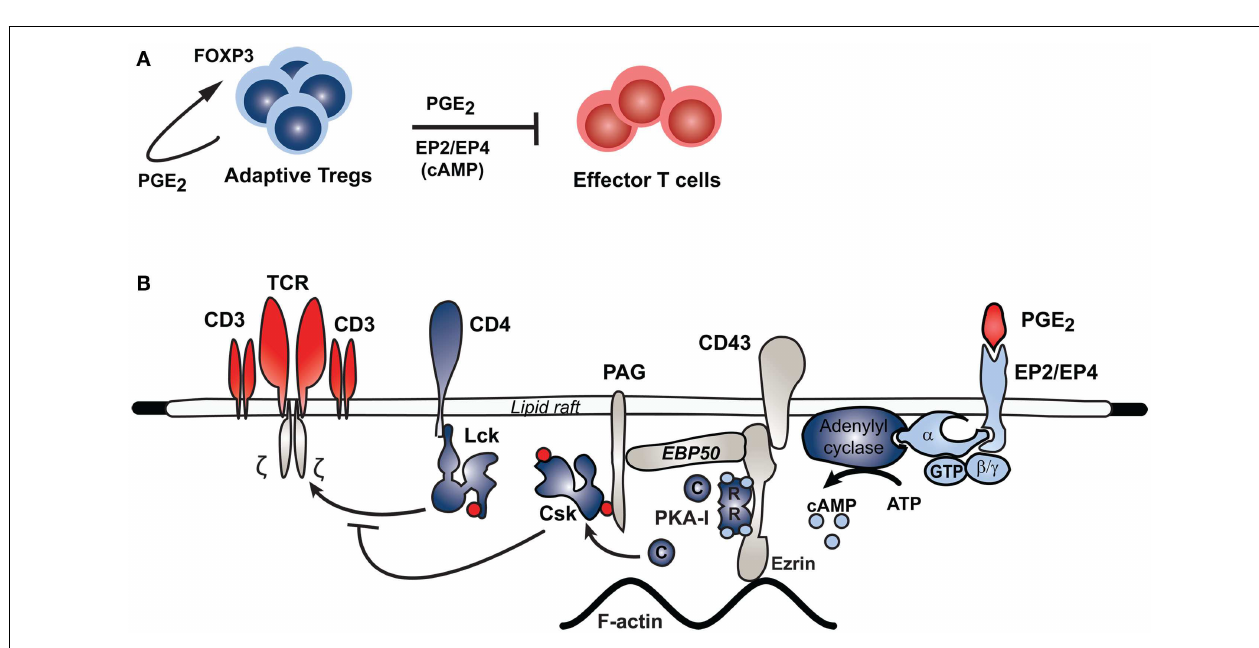
shown in (B) . Binding of PGE 2 to its receptors on effectorT cells stimulates adenylyl cyclase activity, which increases intracellular cAMP levels and thus activates PKA. Aided by an Ezrin-EBP50-PAG scaffold, PKA phosphorylates Csk, which in turn phosphorylates Lck to inhibit its activity. Lck normally acts to promoteTCR signaling; thus Lck inhibition through this PGE 2 -initiated pathway inhibitsTCR signaling in effectorT